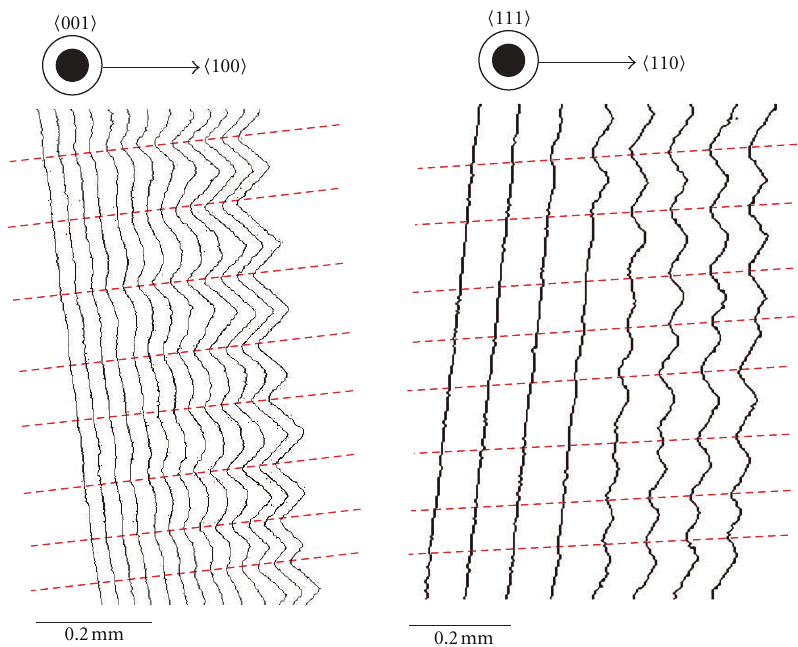
Figure 4: Isochrones of Si (100) and Si (110) interfaces when planar interface transformed to zigzag faceted interface [10].